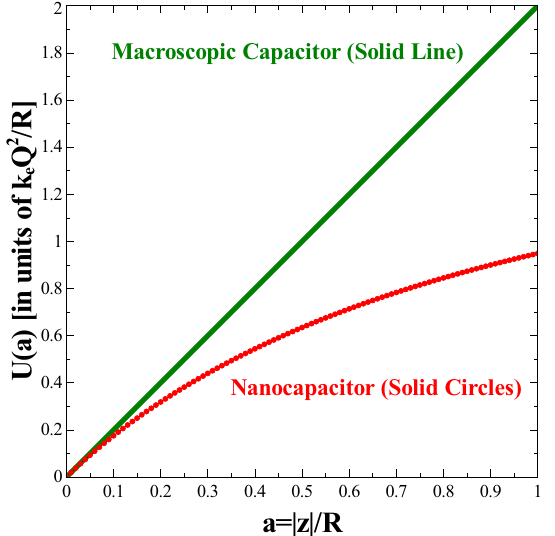
Figure 2. Energy stored in a circular parallel plate nanocapacitor, U ( a ) , in units of k e Q 2 / R as a function of the parameter a = | z | / R (solid circles) where | z | is the separation distance between the two identical circular parallel plates placed opposite to each other and R is their radius. The circular plates contain, respectively, a charge of ± Q . Charge is uniformly spread over each of the two circular plates resulting in uniform surface charge densities, ± σ . The exact result, U ( a ) , is compared to the approximate expression, U linear ( a ) which represents the energy of an ideal macroscopic circular parallel plate capacitor (solid